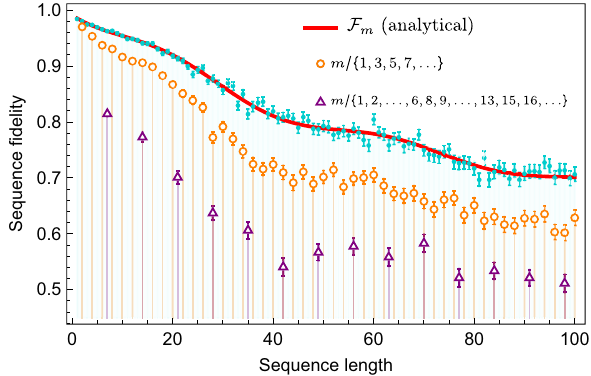
FIG. 7. Diagnosing coherent non-Markovian noise. Inter- leaving identities can allow determination of whether non- Markovian noise is coherent: in a continuous red line we show the analytical ASF with the same model of Eq. (24), with ρ ∼ | 00 (cid:8) , M ∼ | 0 (cid:8) , and same parameters as displayed in Fig. 4, with numerical data displayed by teal points with bars denoting uncer- tainty around the mean; in circles and triangles are shown numer- ical ASFs F m / { i , ... , j } with Cliffords at time steps { 1, 3, 5, . . . } and { 1, 2, . . . , 6, 8, 9, . . . , 13, 15, 16, . . . } set to identity, respectively. Here we show only two examples of F m / { i , ... , j } , not describing an exponential decay, for clarity, but similar behavior occurs inter- leaving identities at any set of steps. Numerical averages are done with 200 sequence fidelity